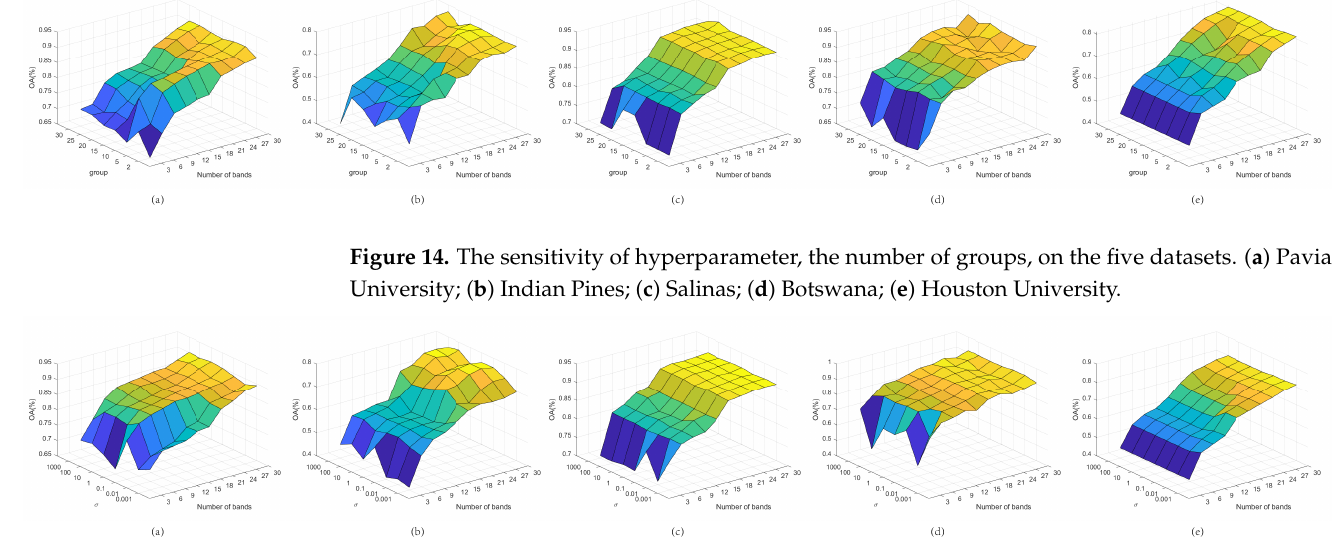
Figure 15. The sensitivity of hyperparameter σ on the five datasets. ( a ) Pavia University; ( b ) Indian Pines; ( c ) Salinas; ( d ) Botswana; ( e ) Houston